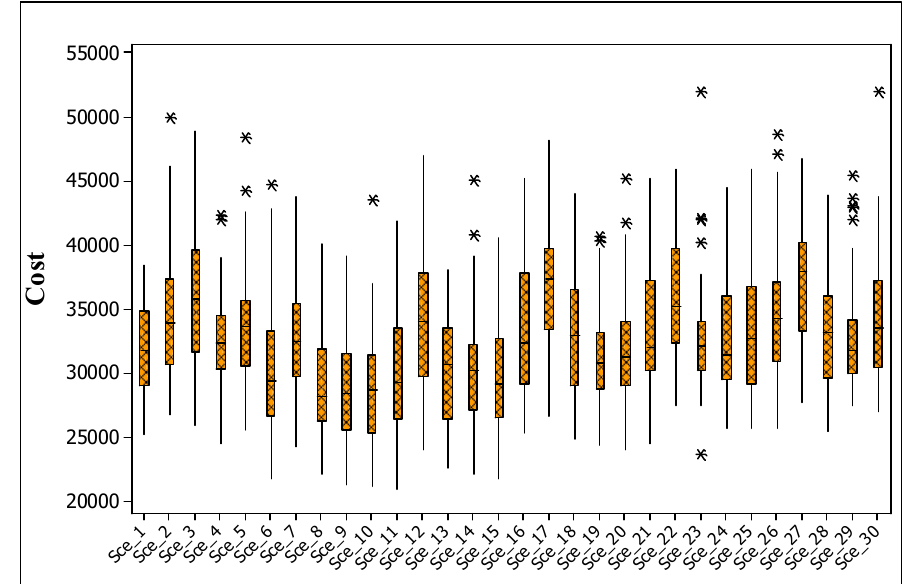
Fig. 4. Total Cost Box Plots for each Scenario Results of Simulation Optimization for First 15 Scenarios Route